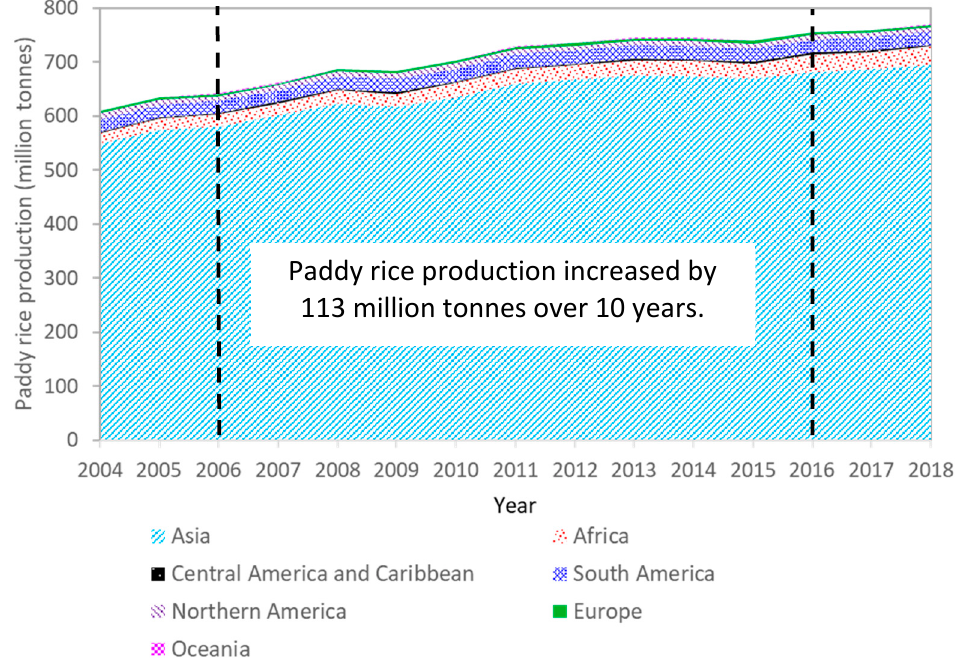
Figure 1. Paddy rice production worldwide (data adapted from reports of FAO between 2006 and 2018 [4–16]); values for 2017 and 2018 are estimated and forecasted data according to the latest report of FAO [4].